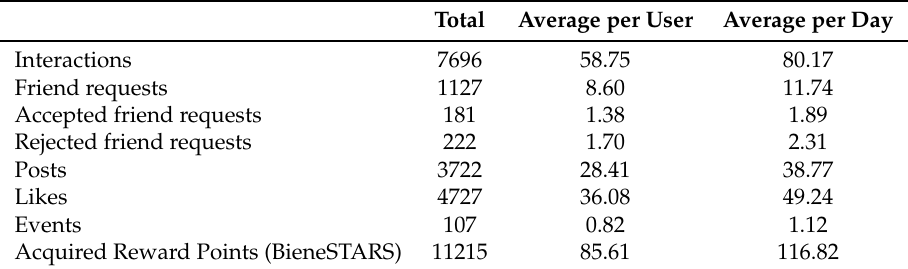
Table 2. Measures obtained in the intervention group to evaluate the use of the application.